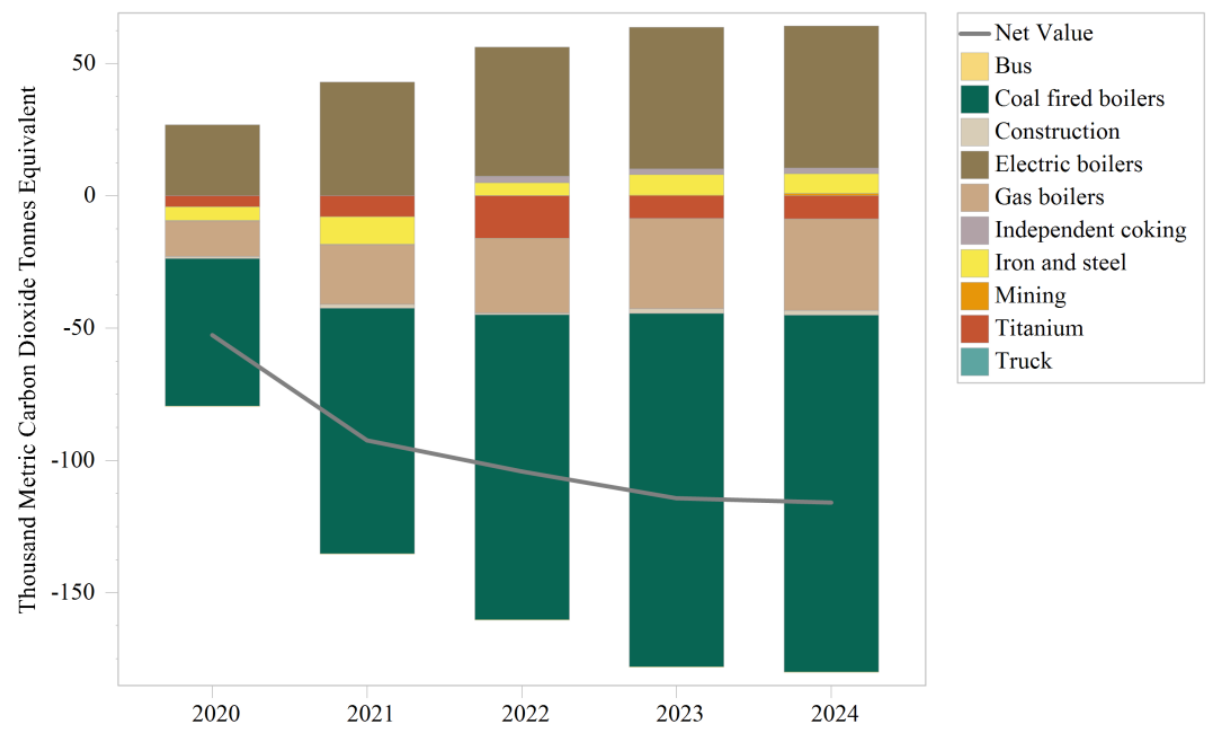
Figure 12. Plot of total carbon emissions for each module against the baseline scenario .